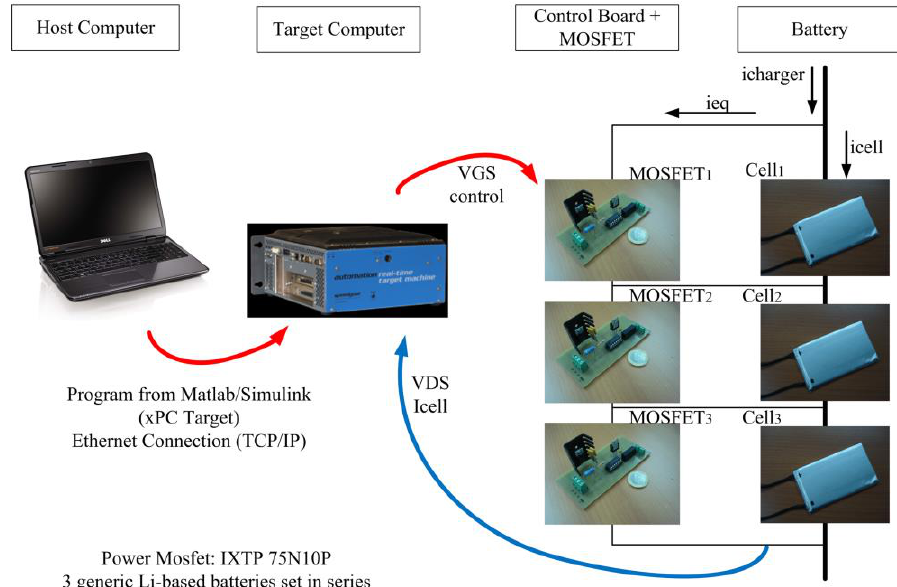
Fig. 7. Schematic of the prototype.